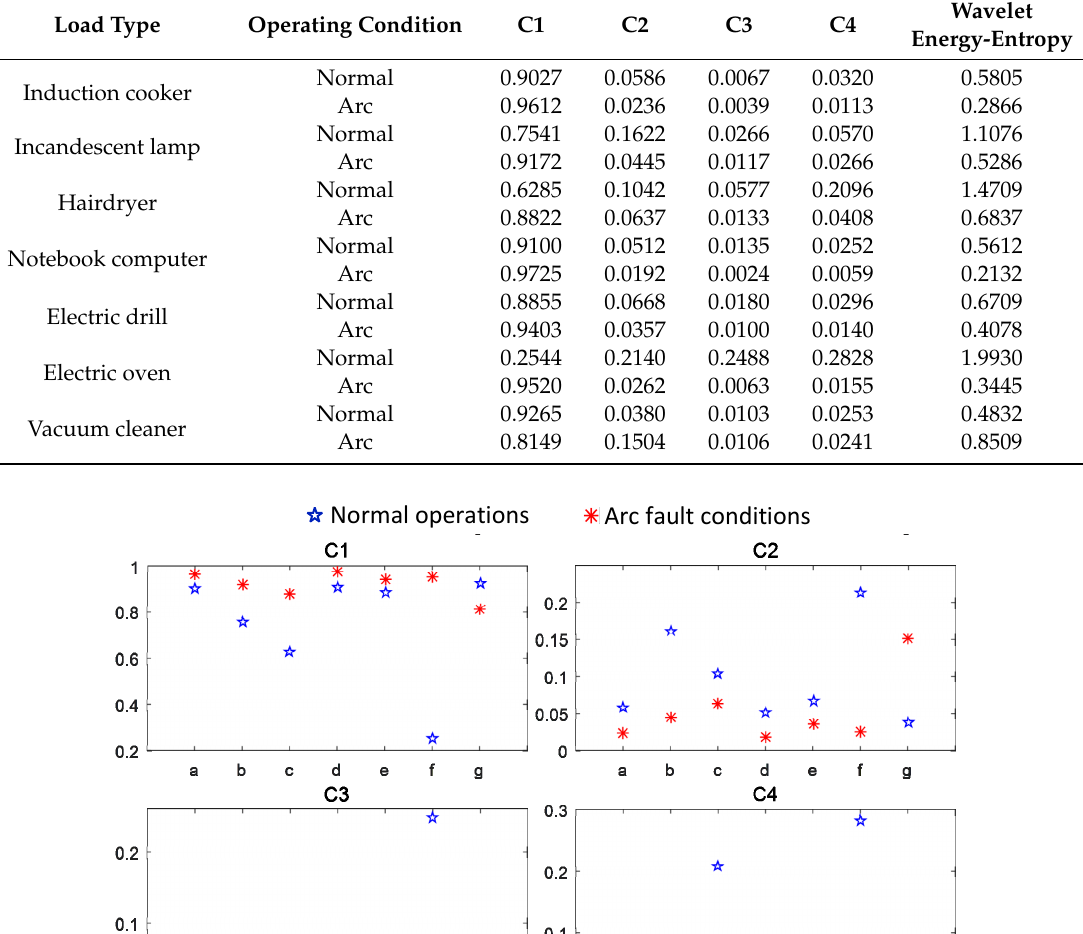
Table3. ThepercentoftheenergyofCjinthewholesignalenergyandthewaveletpacketenergy-entropy.